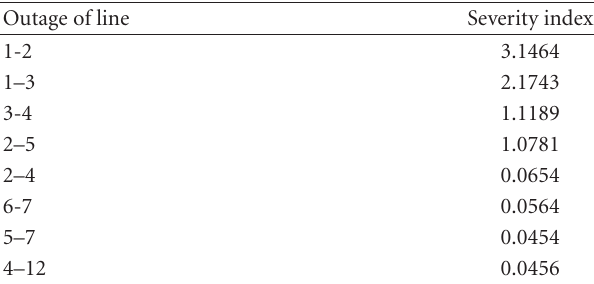
Table 1: Severity index of IEEE 30 bus